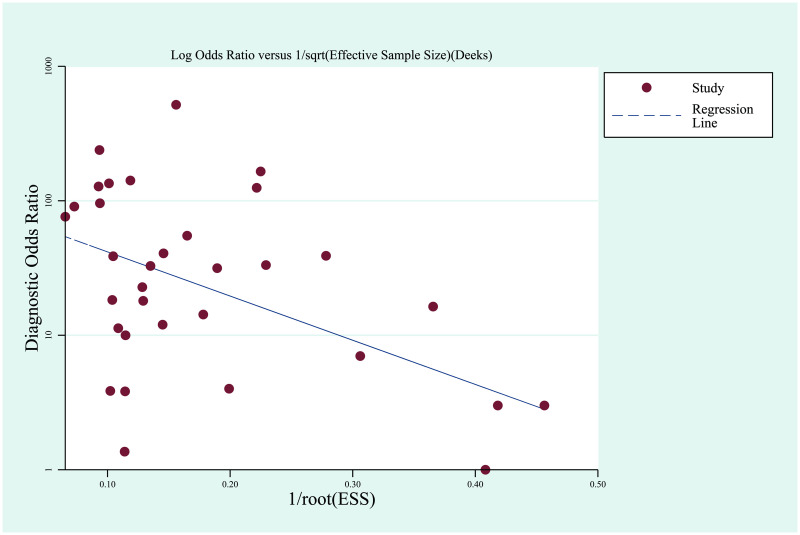
Deek’s funnel plot.